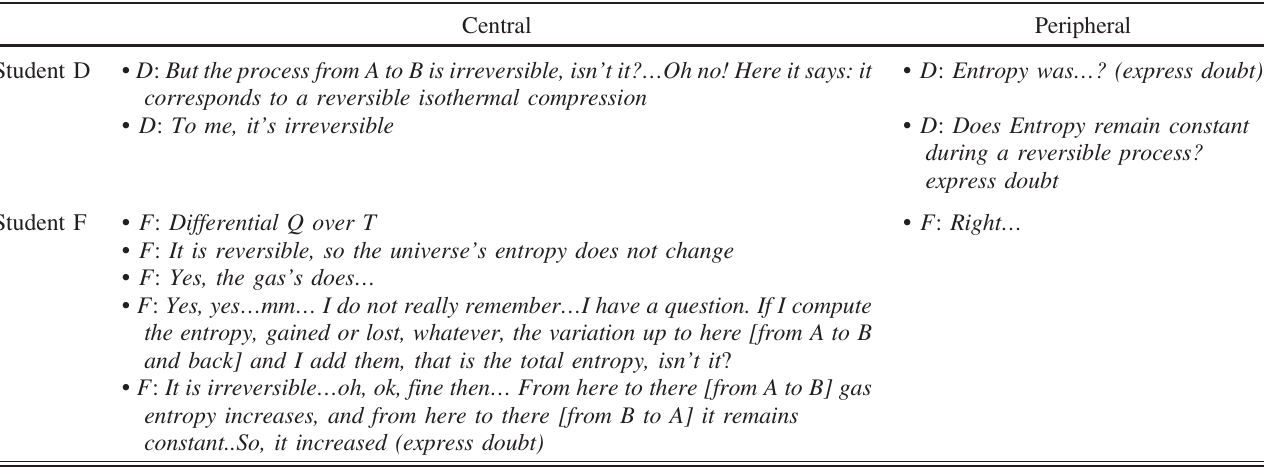
TABLE II. Examples of categorization of participations during segment